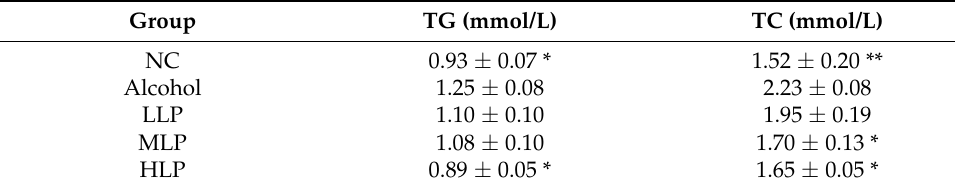
Figure 4. Effects of L. plantarum J26 on serum ALT, AST, ALP and LPS levels. ( a ): ALT activity; ( b ): AST activity; ( c ): ALP activity; ( d ): LPS content. ALT, alanine aminotransferase; AST, aspartate ami- notransferase; ALP, alkaline phosphatase; LPS, lipopolysaccharide; NC, normal control; LLP, low- dose L. plantarum J26; MLP, medium-dose L. plantarum J26; HLP, high-dose L. plantarum J26. The data were analyzed with a one-way ANOVA and expressed as means ± SD ( n = 10). * p < 0.05, ** p < 0.01 and *** p < 0.001 compared with the Alcohol group. Table 2. Lipid content in serum of mice.